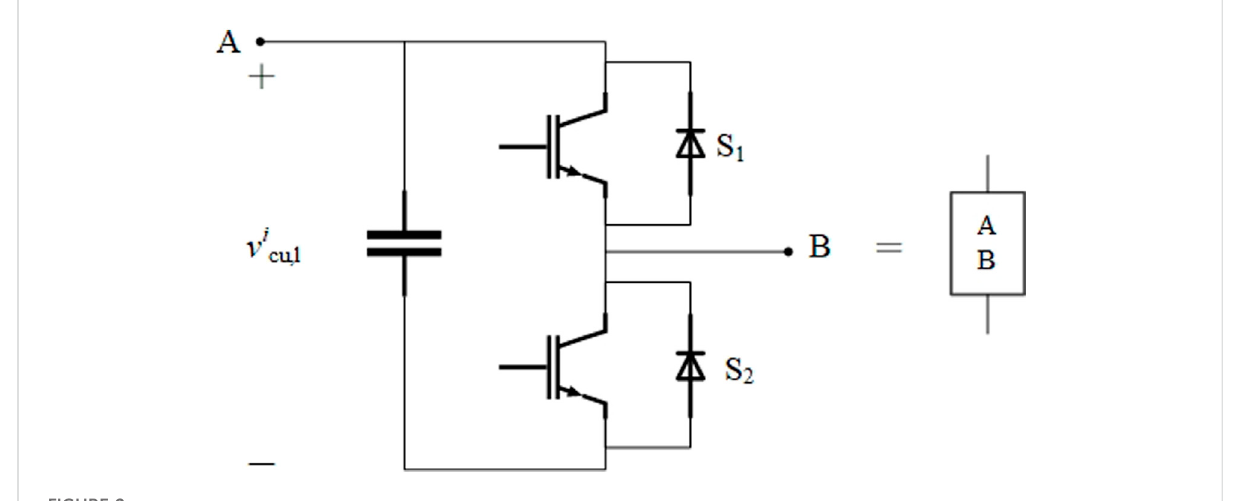
FIGURE 2 A submodule of an